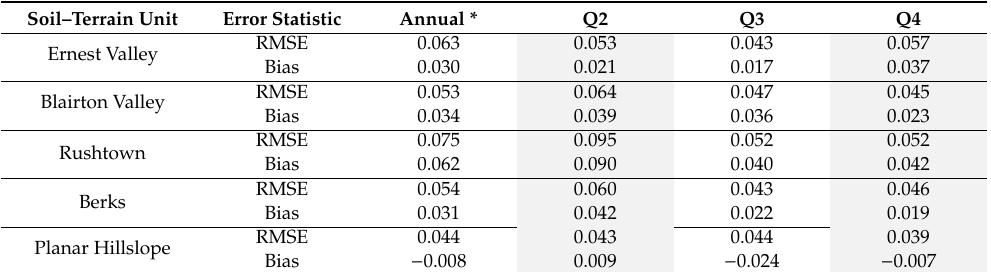
Table 3. Average RMSE and model bias from SMAR predictions compared to observations across manual TDR monitoring locations summarized by soil–terrain unit.